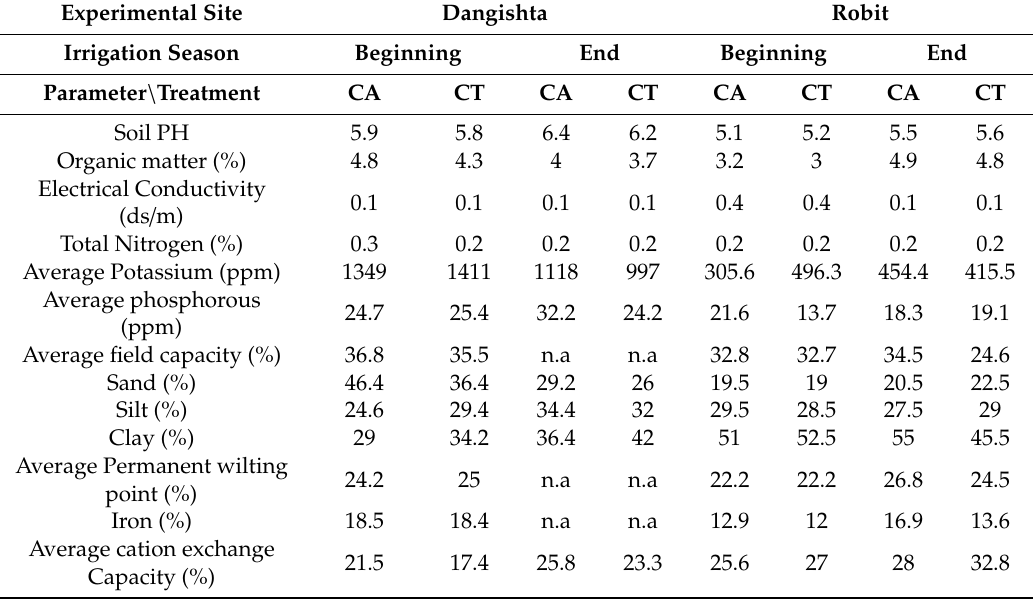
Table 2. Average soil physico-chemical properties during the 3rd cycle vegetable production (Table 1) both at the beginning and end of this experiment. Beginning stands for before transplanting, end stands for immediately after harvest during 3rd cycle vegetable production (after two years of conservation agriculture (CA)